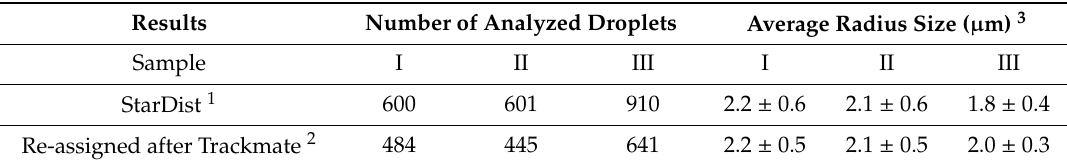
1 Minimum number of droplets per sample from segmented images that were recorded over 10 days. 2 Re-assigned details are explained in the Supplementary Materials (Figure S4). 3 Standard deviation in droplet radius sizes